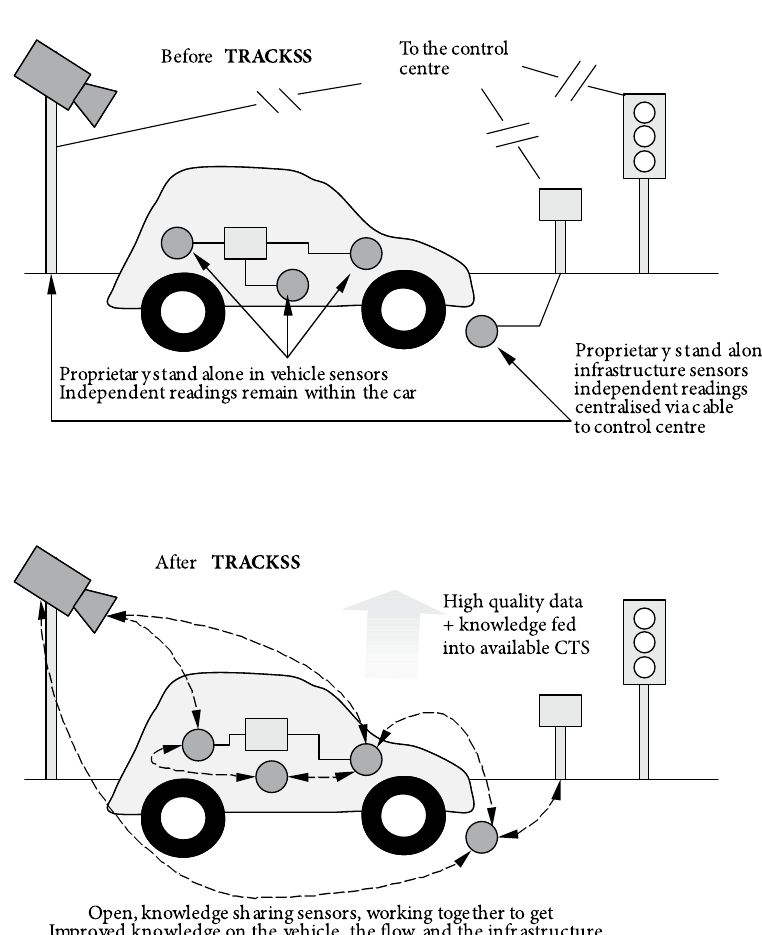
Fig. 1. The solutions to transport systems before and after the